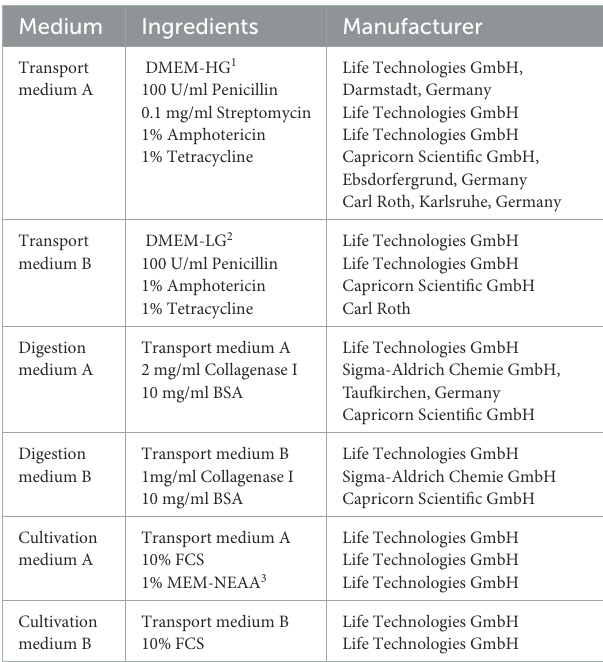
TABLE 2 Composition of medium used for isolation and